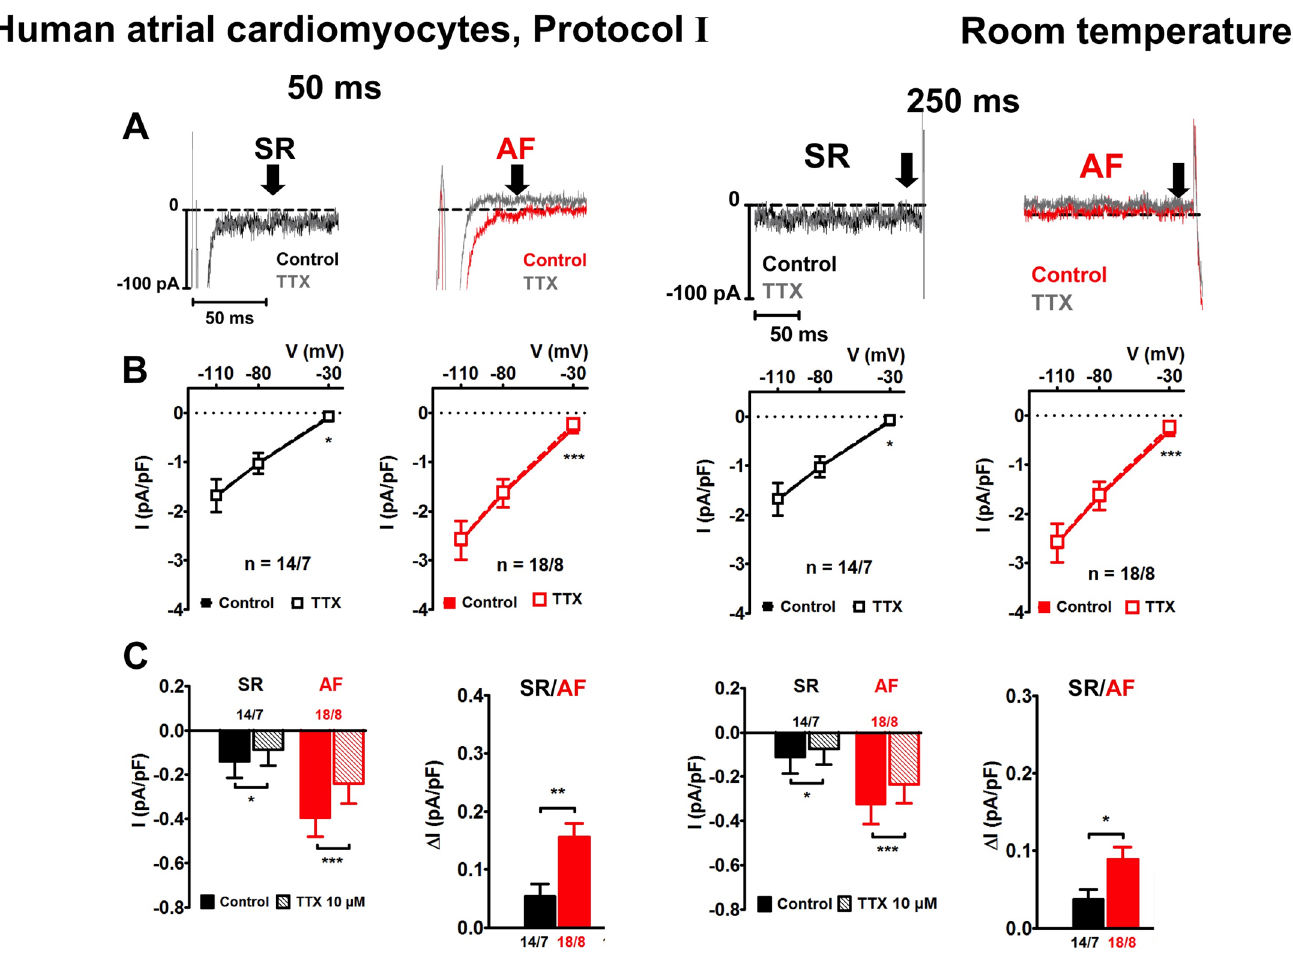
Fig 2. Effects of tetrodotoxin on I Na,late in human atrial myocytes from patients in sinus rhythm (SR, black) and atrial fibrillation (AF, red) 50 ms and 250 ms after Na + channel activation. A Examples of original current tracings (top) measured at room temperature with protocol Ⅰ , under control conditions and in the presence of 10 μ M TTX. Late sodium currents were measured 50 ms (left side) 250 ms (right side) after the beginning of the pulse at -30 mV (black arrow). B : Current density plotted for each voltage yielded a straight line after addition of TTX. C : Effect of 10 μ M TTX on currents expressed as current density (in pA/pF) at -30 mV in SR and AF cardiomyocytes, and * P < 0.05, *** P < 0.001; paired Student ’ s t-test ( B, C ) for currents before and after exposure to TTX, or unpaired Student ‘ s t test with Welch ’ s correction for TTX-sensitive current in SR and AF.